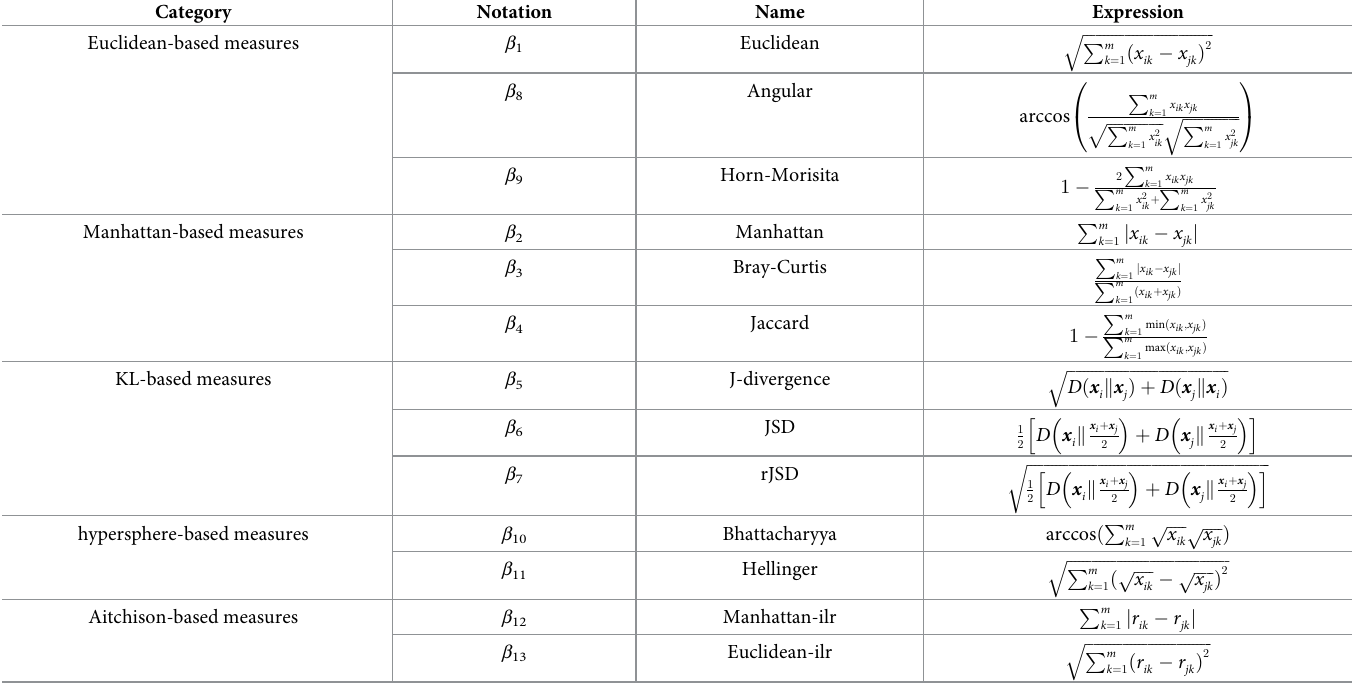
Table 1. Definitions of different beta diversity